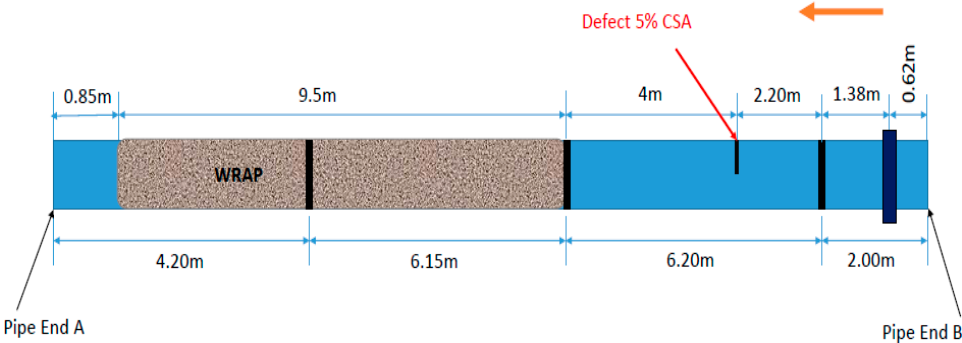
Figure 10. Set-up for Pipe B, including wrapping and a 5% CSA defect. The welds are illustrated as black lines.